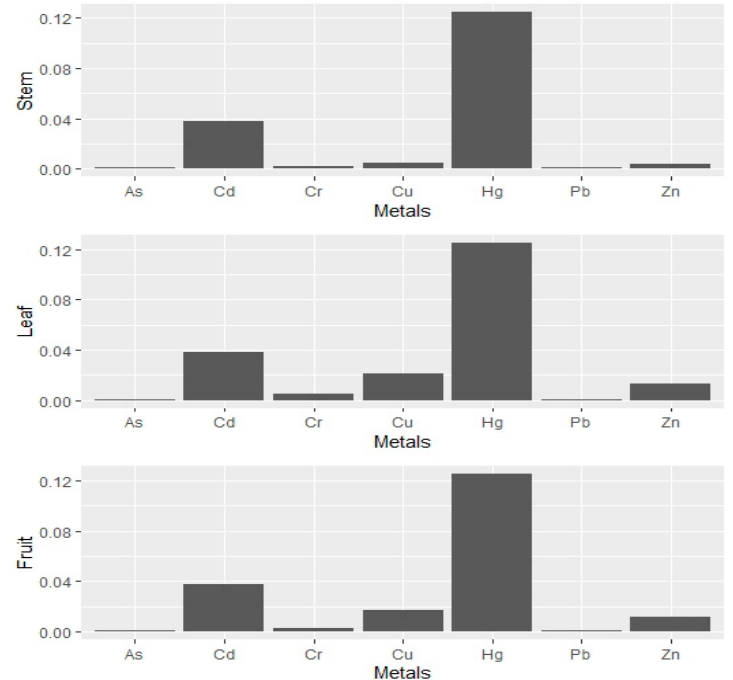
Figure 5. BSAF stem, leaf, fruit ‐ sediment.